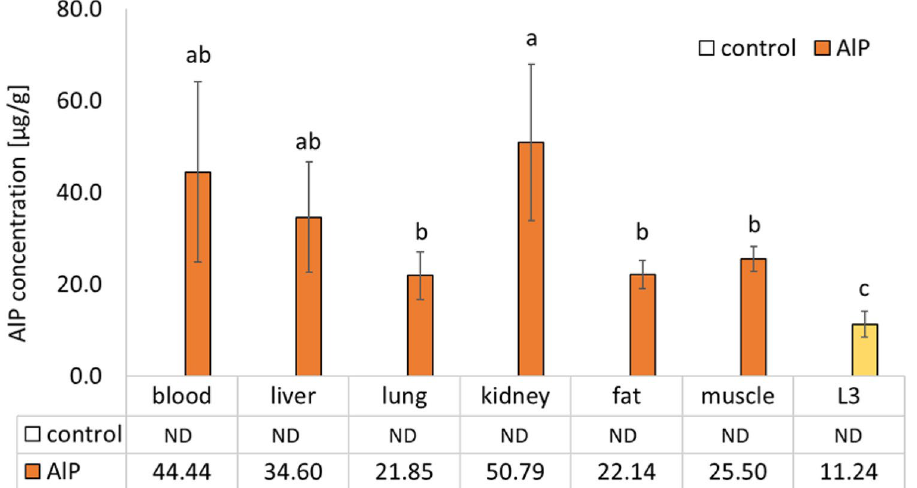
Figure 1. Aluminum phosphide (AlP) concentrations (mean ± SD) in blood and tissues of AlP-treated rabbits (AlP group) and the third instar of Chrysomya albiceps larvae (L3) fed on rabbits’ carcasses. The concentration of AlP in the control group was below the detection limit. The same letters denote no significant differences (ANOVA, LSD test, p < 0.05). ND not